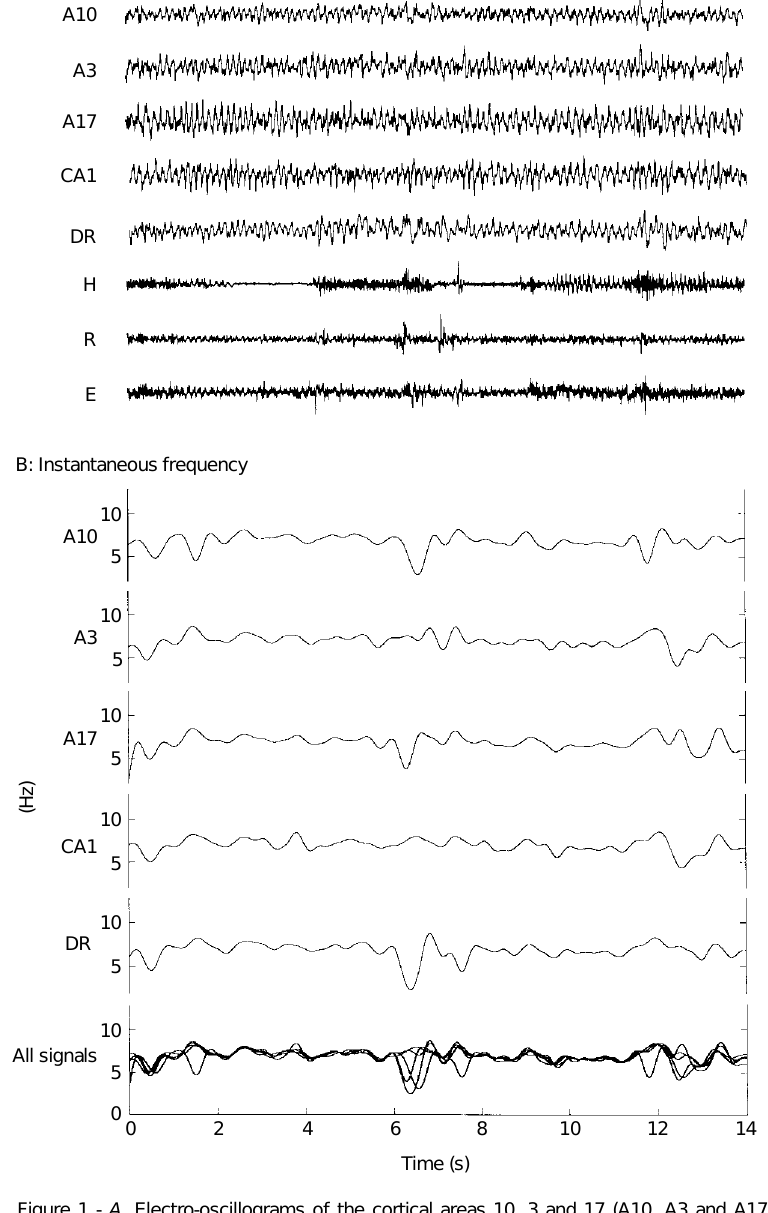
Figure 1 - A , Electro-oscillograms of the cortical areas 10, 3 and 17 (A10, A3 and A17), hippocampal CA1 (CA1) and dorsal raphe nucleus (DR) during attentive wakefulness with exploratory behavior, expressed as intense movements of the head (H), rostrum (R) and eyes (E). Theta rhythm appears as regular and well-modulated waves. B , Instantaneous frequency variation of the same brain structures as shown in A. A close coupling of frequency values occurs from 2 to 6 and from 8 to 12 s (oscillation, i.e., modulation, band near 2 Hz). Brief desynchronization episodes concomitant to the more active behaviors appear as uncoupling of frequency in the concomitant electro-oscillograms from 6 to 8 and above 12